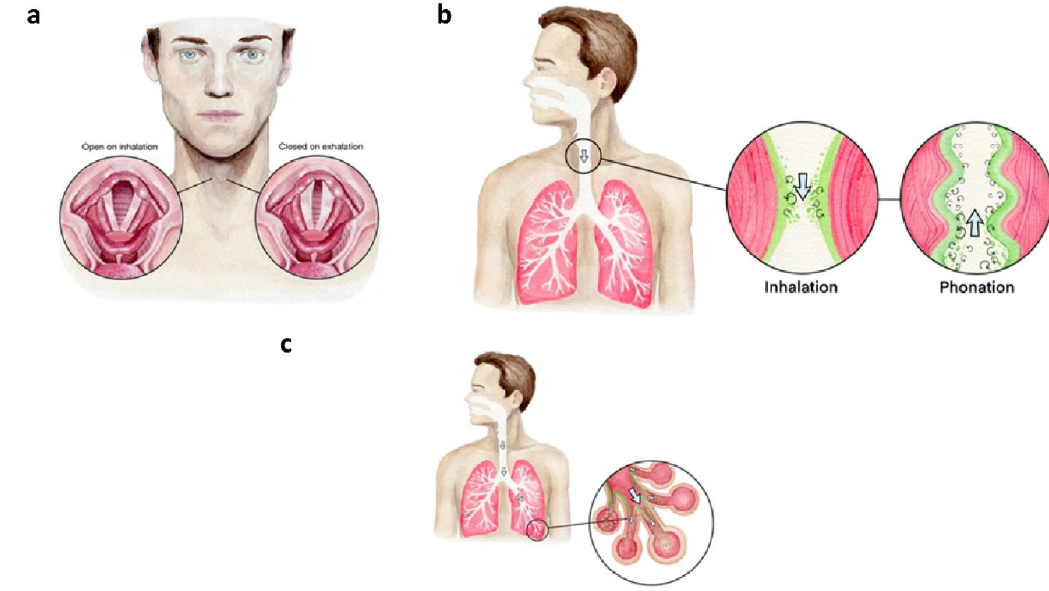
Figure 1. Artist renderings of the upper airways under normal and dehydrated conditions. ( A ) The human glottis during open (inhalation) and closed (exhalation) normal tidal breathing; ( B ) Airflow, droplet generation and turbulent eddies in the human larynx on normal inhalation; ( C ) Airflow, droplet generation and turbulent eddies on speech (phonation with